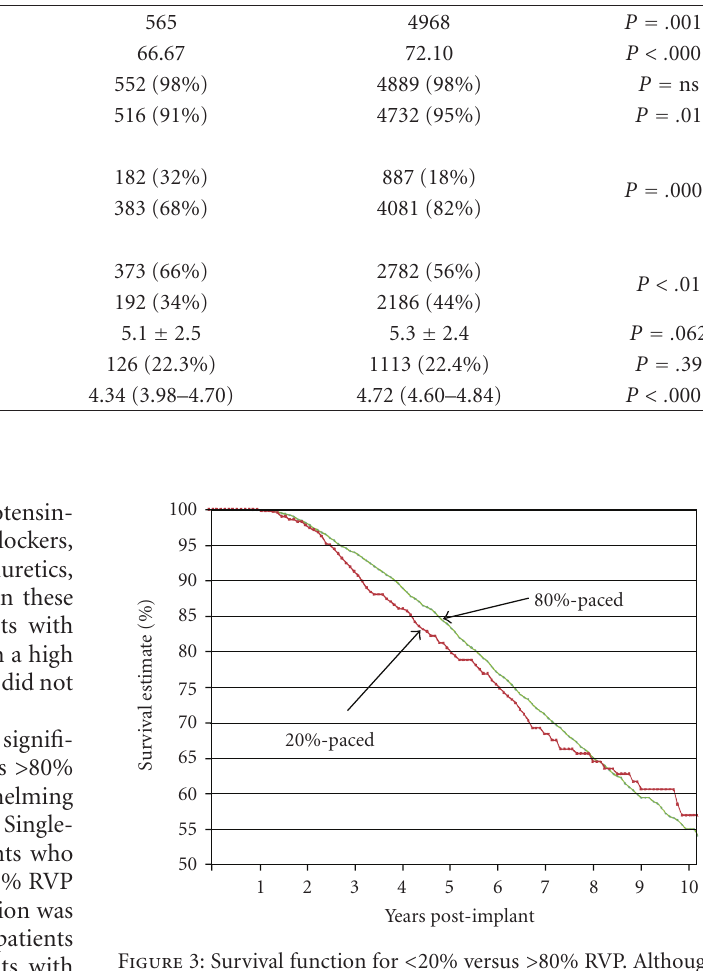
(Table 5). In multivariate analysis, patients with > 80% RVP lived significantly longer than patients with < 20% RVP (Chi- square = 9.92; P = .